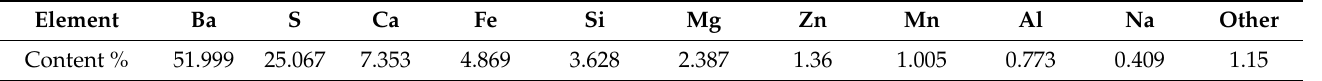
Table 1. Analysis of solid phase elements in oil sludge.